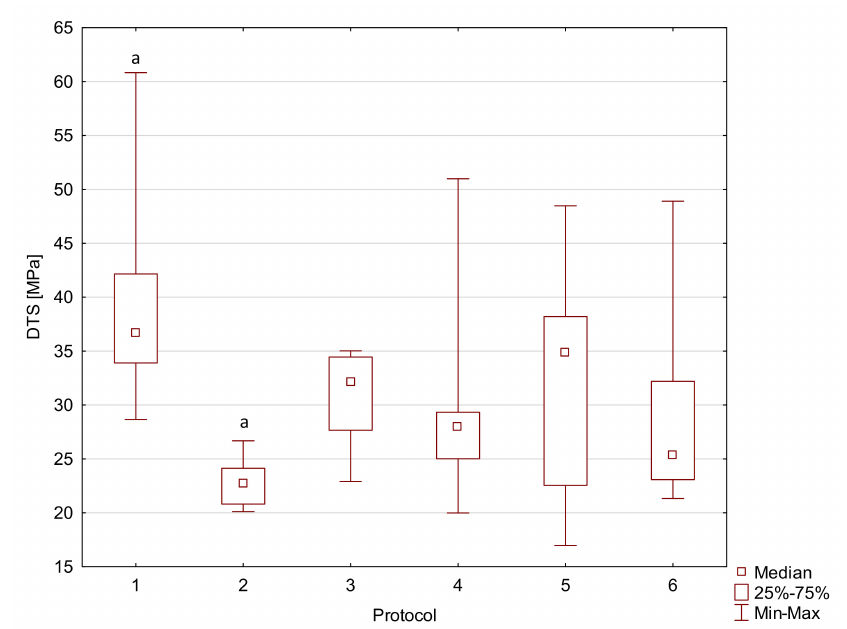
Figure A2. Box-and-whisker plot of diametral tensile strength (DTS)) of Resin F material. Statistically- significant differences were detected between the following: (a) Protocol 1 (water, 24 h, 37 ◦ C) vs. (a)